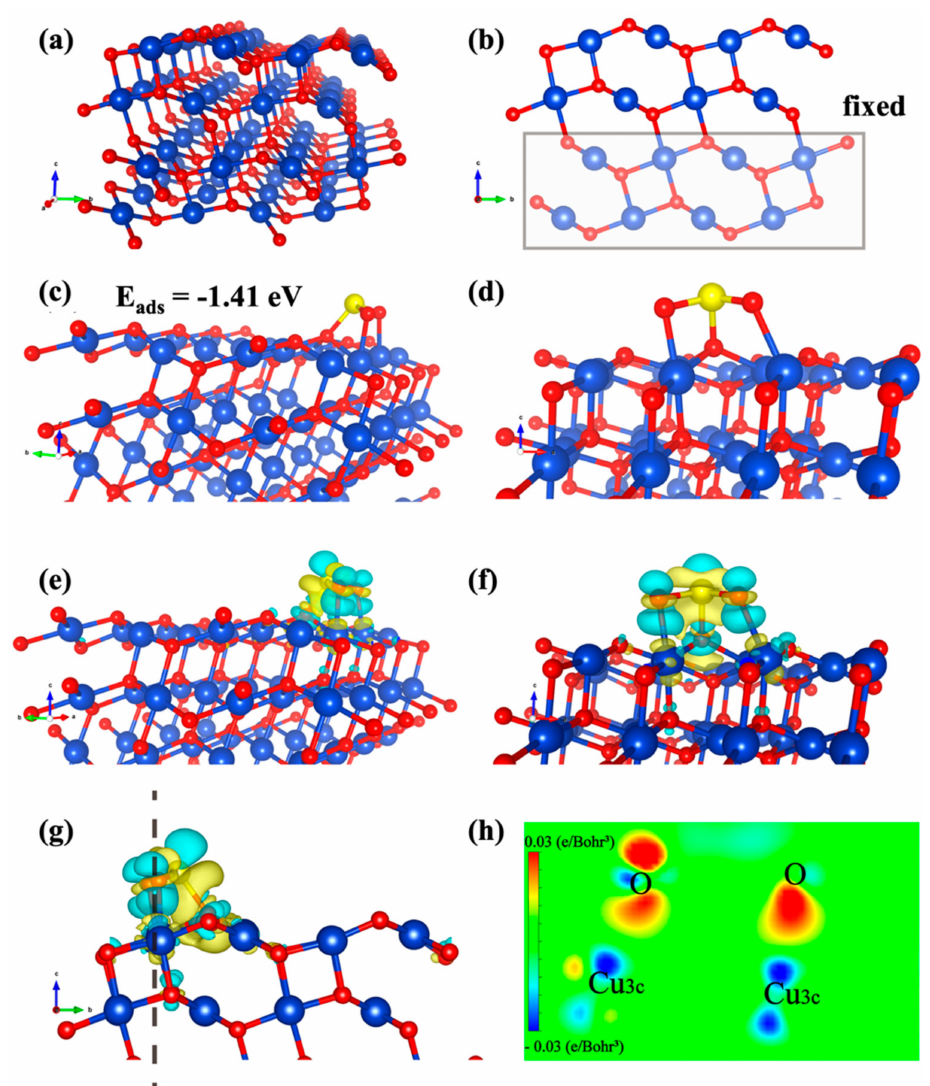
Figure 4. Adsorption configurations of SO 2 molecules over simulated CuO − NC (111). (Cu, O and S atoms are depicted in blue, red and yellow, respectively). ( a ) The unit cell of CuO (111). ( b ) The front view. ( c ) The adsorption configurations of the SO 2 − adorbed intermediate. ( d ) The side view. ( e ) The CDD diagrams of the SO 2 adsorption over CuO surface. ( f , g ) The corresponding side and front views, respectively. (The yellow and the turquoise region refer to the charge consumption and accumulation, respectively). ( h ) The 2D sectional view of CDD